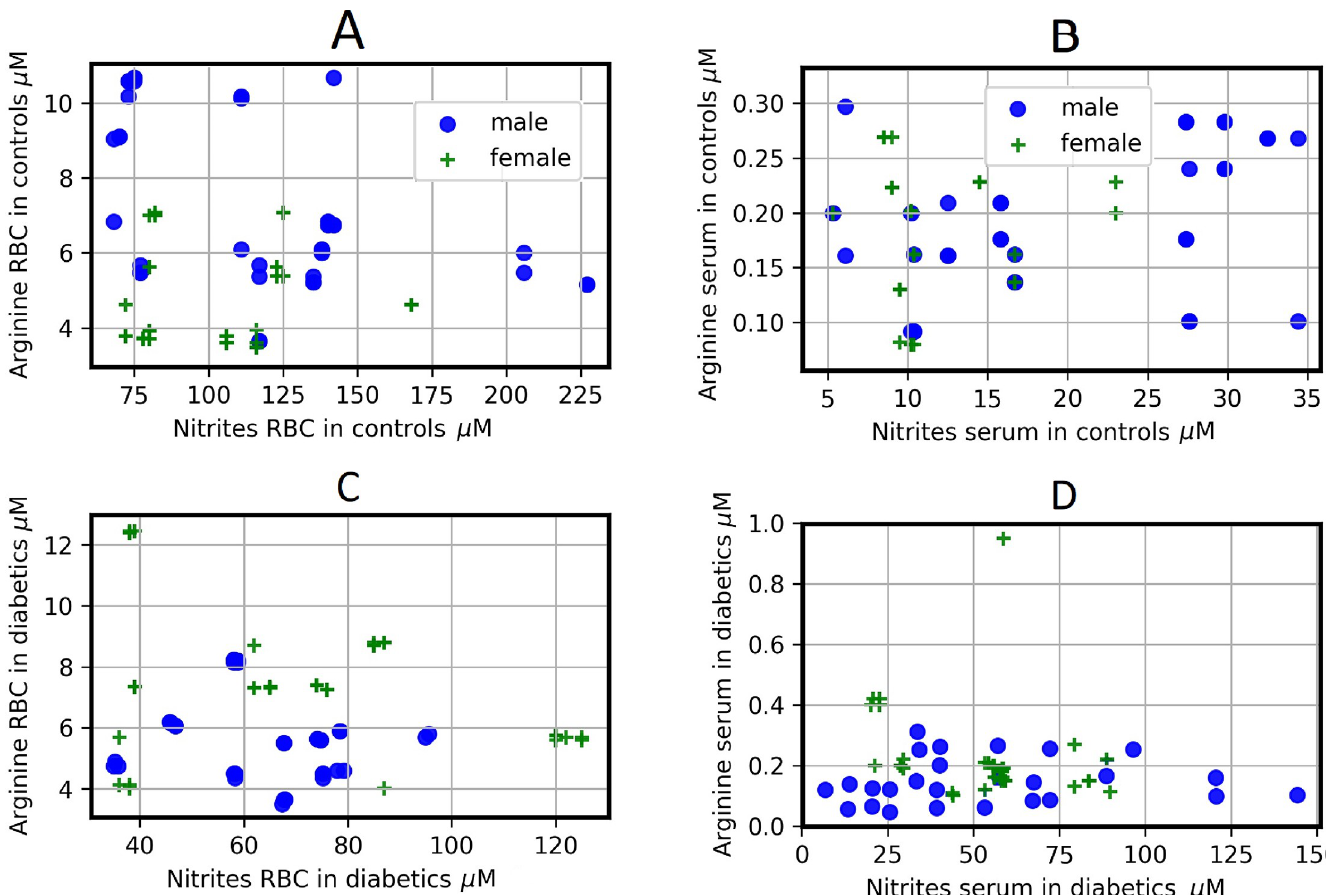
Fig 6. Scatter plots for different determinations for controls and diabetic patients according to gender (males are circles and females are stars) and RBC (left column) or serum (right column). Scatter plots show the relation between two sets of data; this relation is summarized in the Spearman correlation coefficients. These correlations are: A (rM = -0.439, rF = 0.269), B (rM = 0.276, rF = -0.22), C (rM = -0.2578, rF = -0.179), D (rM = 0.229, rF = -0.361). To see the p-values for each correlation, see the correlation matrix (S3 File).